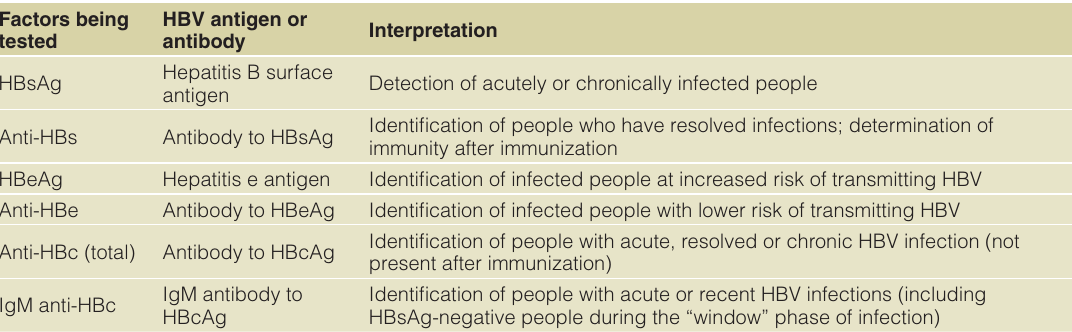
Table 2. Diagnostic Tests for